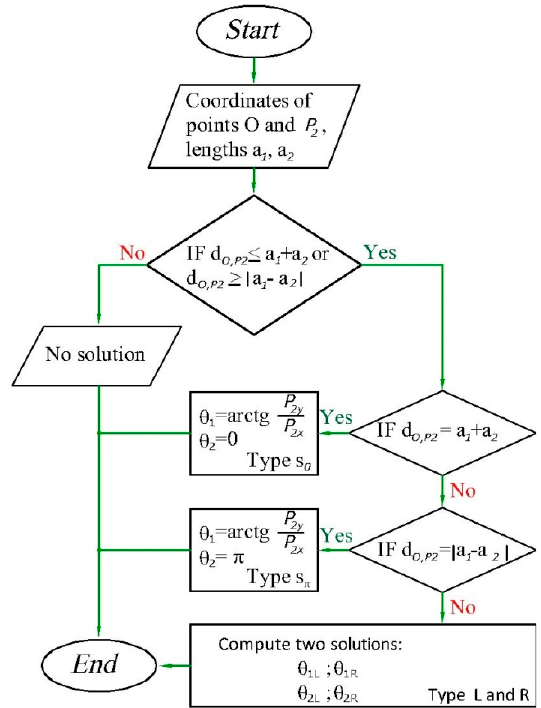
Figure 9. Algorithm for finding an IK solution for a two-link mechanism and determining its type according to Definitions 1–3.